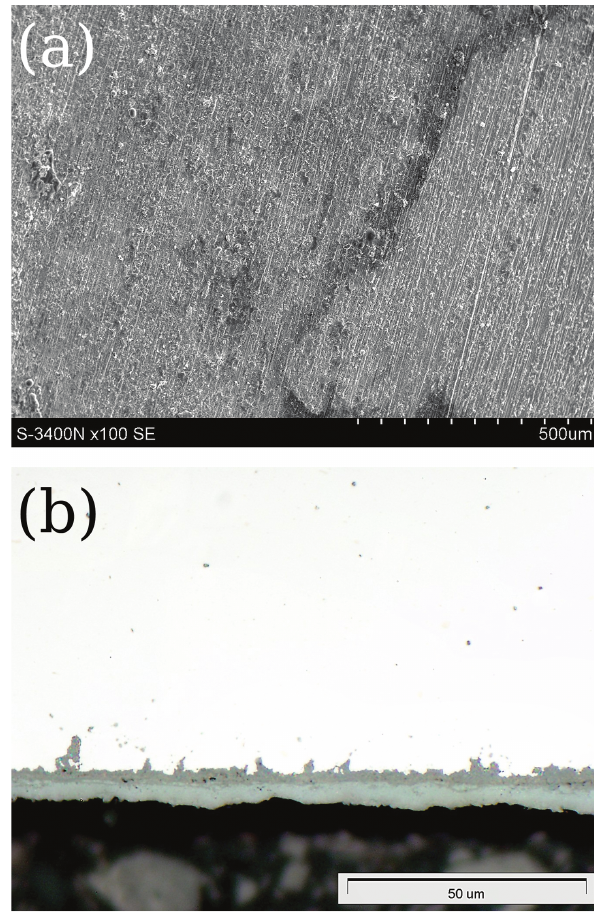
Figure 4: Morphology of the scale formed on the Super 304H steel during oxidation under thermal shock conditions: (a) scale surface (b) cross-section of oxidized